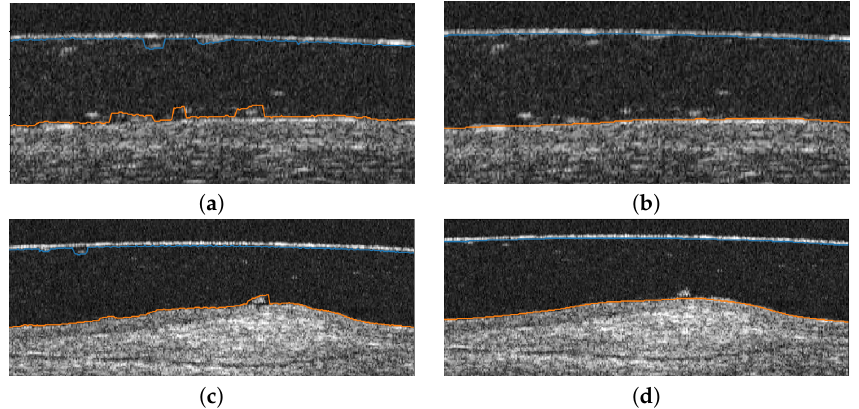
Figure 9. Example of the results of the segmentation phase in different AS-OCT images. ( a , c ) Preliminary localizations. ( b , d ) Result after applying the snake to the ( a , c )